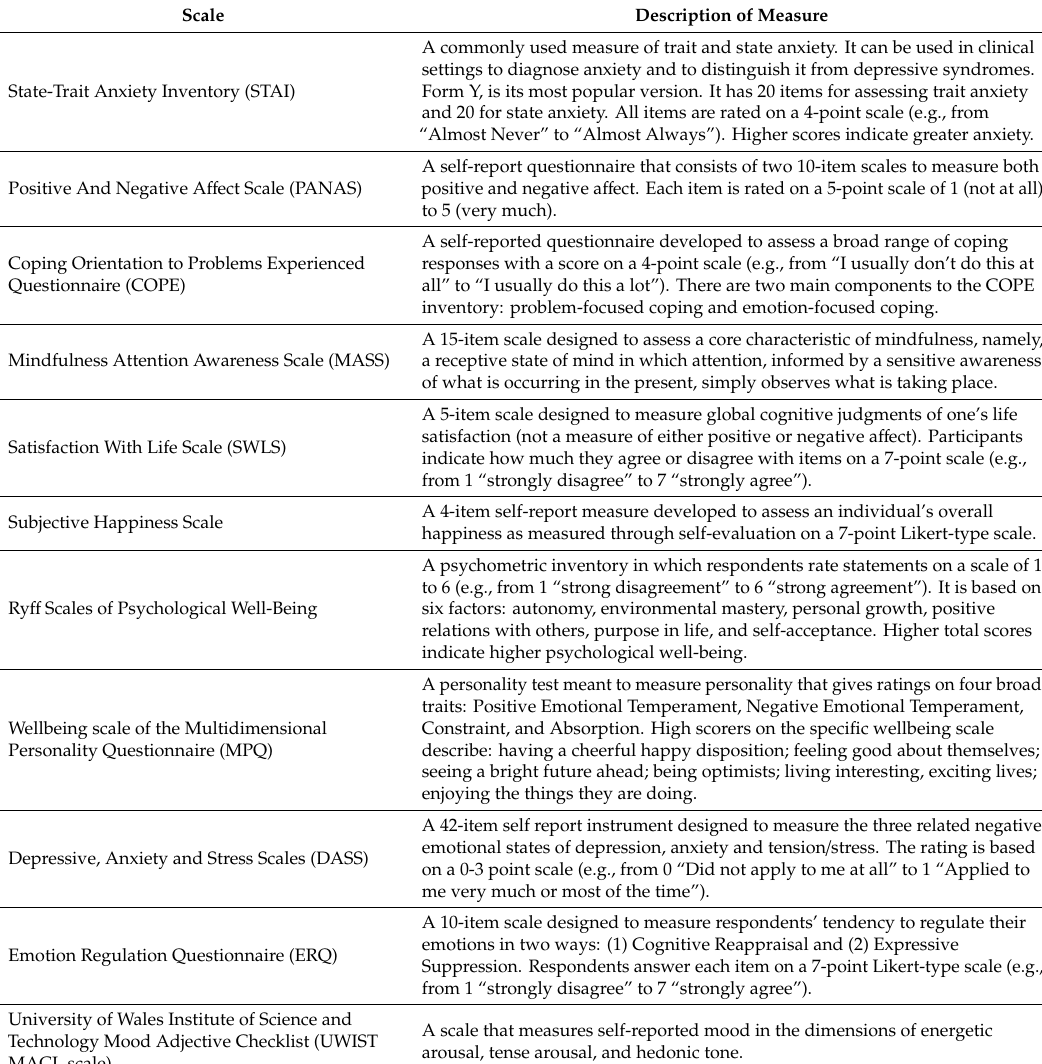
Table 6. Wellbeing Measure Scales